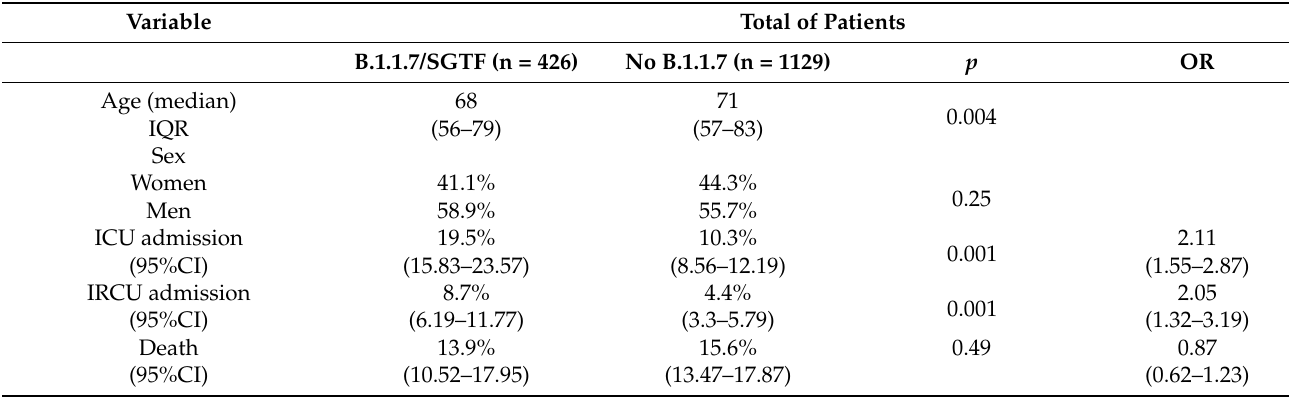
Table 1. Demographic and clinical characteristics of the patients infected by B.1.1.7 and non-B.1.1.7 lineages. IQR: interquartile range, OR: odds ratio, 95%CI: 95% confidence interval, ICU: intensive care unit, IRCU: intensive respiratory care unit, sig: